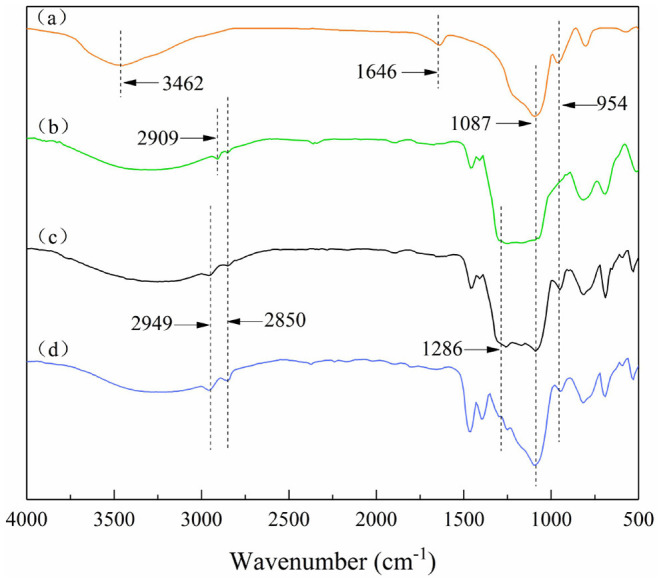
Fourier transform infrared spectra of particles. (a) Bare silica particles; (b) Uniformly modified particles covered with fluorocarbon chains on the surface; (c) JP1s mostly covered by fluorocarbon chains; (d) JP2s mostly covered by hydrocarbon chains.